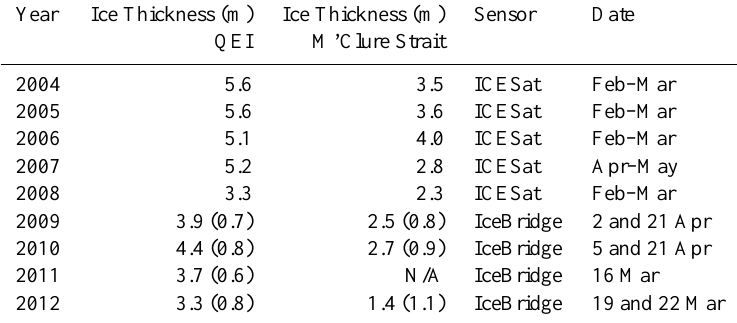
Table 1. ICESat and IceBridge ice thickness estimates within the Canadian Basin just north of the Arctic Ocean–Queen Elizabeth Islands (QEI) and Arctic Ocean–M’Clure Strait ice exchange gates, 2004–2012. IceBridge mean uncertainty in brackets.